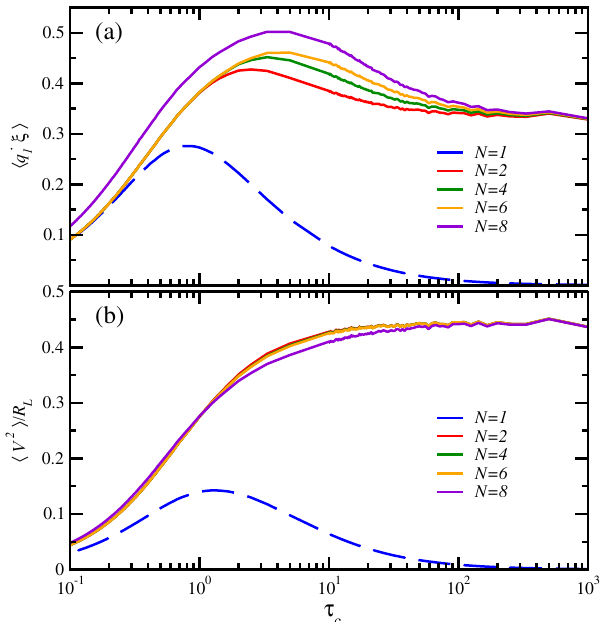
Figure 2. ( a ) Simulation results of the energy harvester harmonic chain. We plot the power delivered by the noise to the first element of the chain, �˙ q 1 ξ � , for a wide range of values of the ambient noise correlation time τ c : the single oscillator with N = 1 (blue dashed line), and chains of length N = 2 (red), N = 4 (green), N = 6 (orange), and N = 8 (violet). ( b ) Total electric power harvested from the ambient fluctuations (cid:31) V correlation time τ c . In both panels the parameters are σ = 2 in all considered instances. τ p = R L